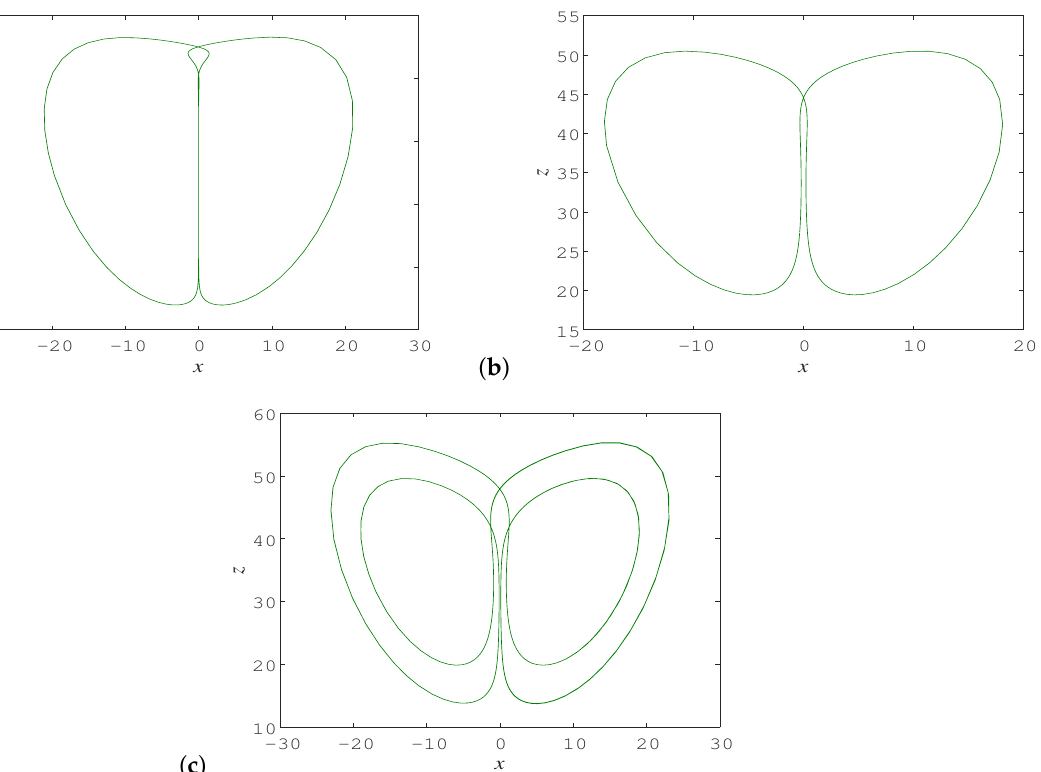
Figure 4. Two-dimensional view of different periodic attractors of system (2), a = c = 35 and d = 10: ( a ) b = 0.3; ( b ) b = 1; ( c ) b =